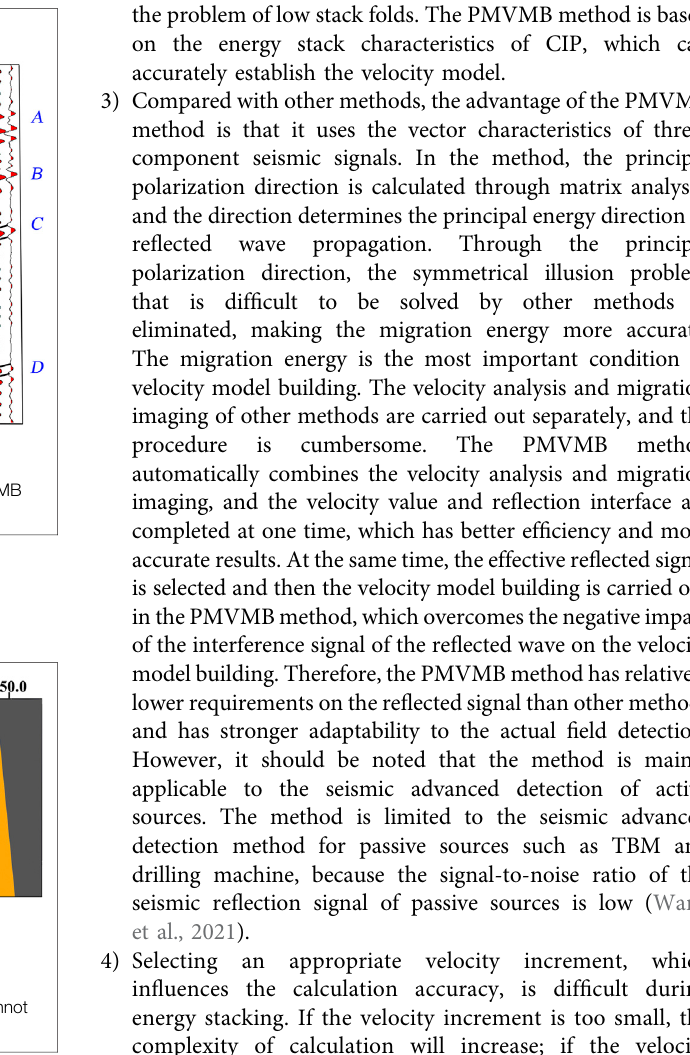
Frontiers in Earth Science |